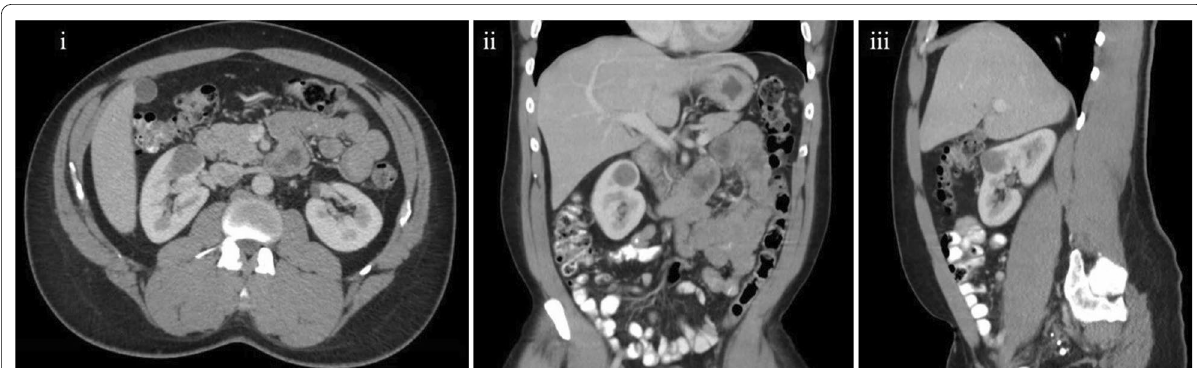
Fig. 1 CT images of right renal mass: i selected axial image; ii selected coronal image; iii selected sagittal